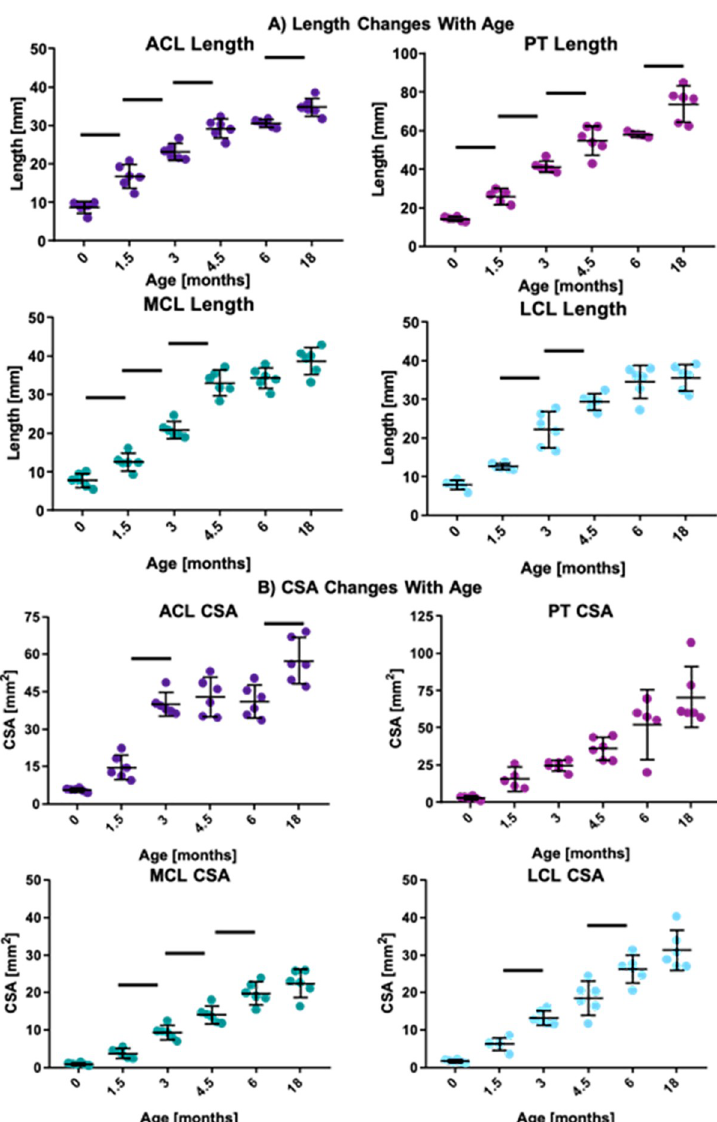
Fig 3. Length (A) and CSA (B) increase several fold in the ACL, PT, MCL, and LCL from birth through skeletal maturity. Data for individual specimens are presented as points while mean and 95% confidence intervals are represented by dashes and lines. Bars represent significant differences between consecutive age groups (p <